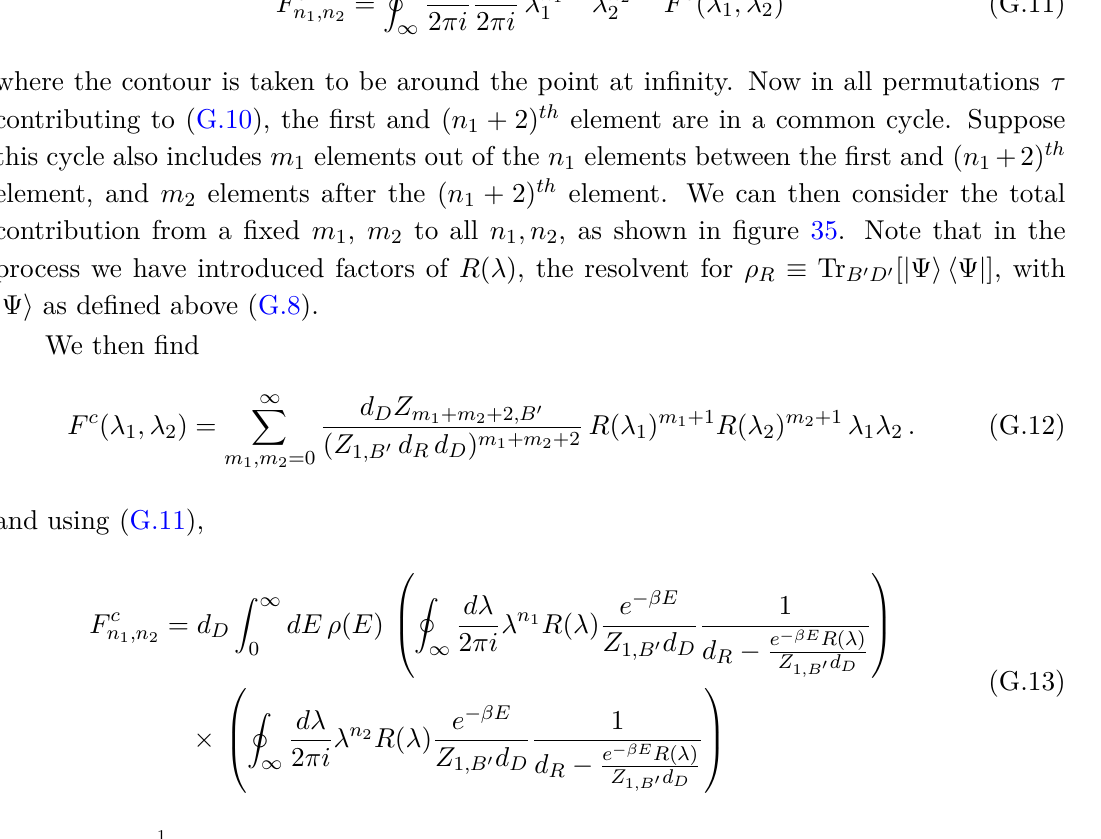
, and we get m ( d D d R Z 1 ,B 0 ) m 1+ m 2+2 , λ ( λ ) , 1 and λ ( λ ) , leading to 1 R 1 2 R 2 λ 1 λ 2